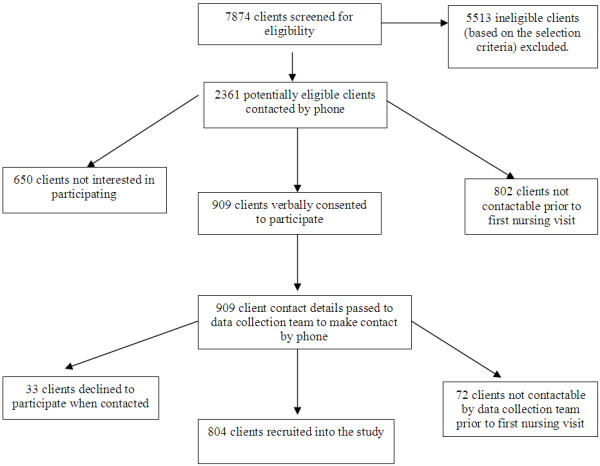
Client recruitment process and baseline data collection.